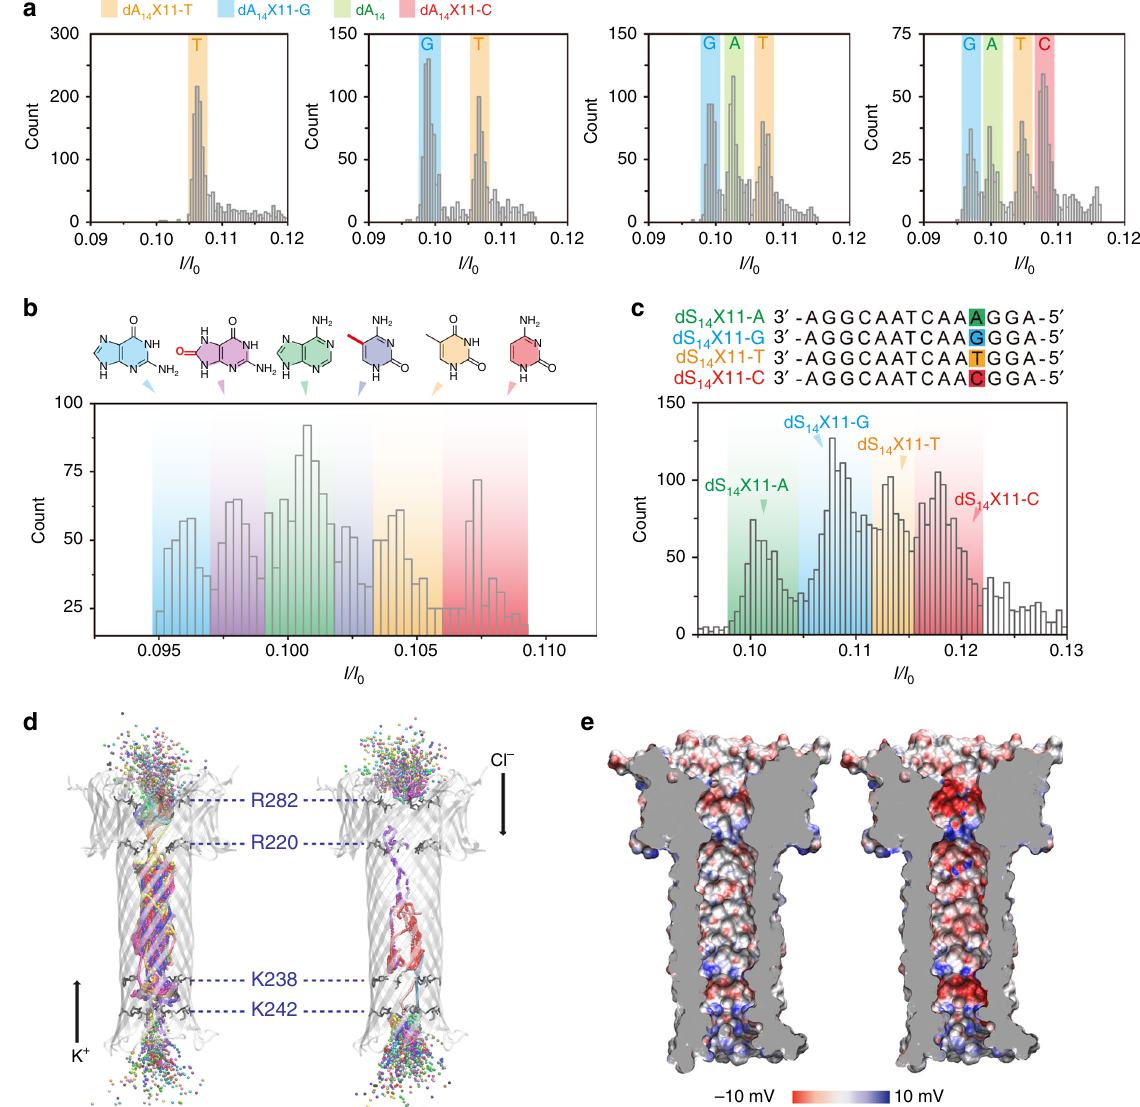
Fig. 4 Discrimination of all four DNA bases by dA 14 X11 sites of the aerolysin nanopore. a The I/I 0 histograms of dA 14 X11-T; dA 14 X11-T and dA 14 X11-G; dA 14 X11-T, dA 14 X11-G, and dA 14 ; dA 14 X11-T, dA 14 X11-G, dA 14 , and dA 14 X11-C, from left to right. The number of blockades in each histogram is at least 2000. b The I/I 0 histograms for aerolysin pore interrogated with six kinds of oligonucleotides that only differ at the position of 11 (four kinds of normal base: A, T, C, G and two kinds of damage nucleobases: m C and o G). The number of blockades is 4500. c Histograms of I/I 0 caused by the four kinds of nucleobase in a heteropolymeric DNA strand. The sequence information of four ssDNA is illustrated at the top of the fi gure. The data were obtained for 3.0 M KCl, 10 mM Tris, and 1.0 mM EDTA, pH = 8.0, 17 ± 2 °C at the bias potential of + 100 mV. The number of blockades in each histogram is at least 5000. d Potassium (left) and chloride (right) ion occupancy at each 0.1 ns of the MD simulation. The DNA (dA 14 ) is not shown for sake of clarity. Ions are represented as spheres colored according to residue ID. Amino acids R282, R220, K238, and K242 are shown as black sticks. e Electrostatic surface of aerolysin pore lumen as calculated with the APBS-PDB2PQR server 59,60 , without (left) or with (right) dA 14 inserted in the pore. The DNA is not shown for the sake